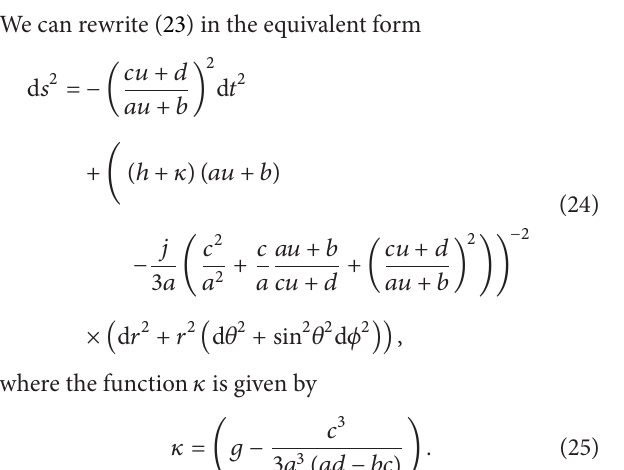
Figure 4: Speed of